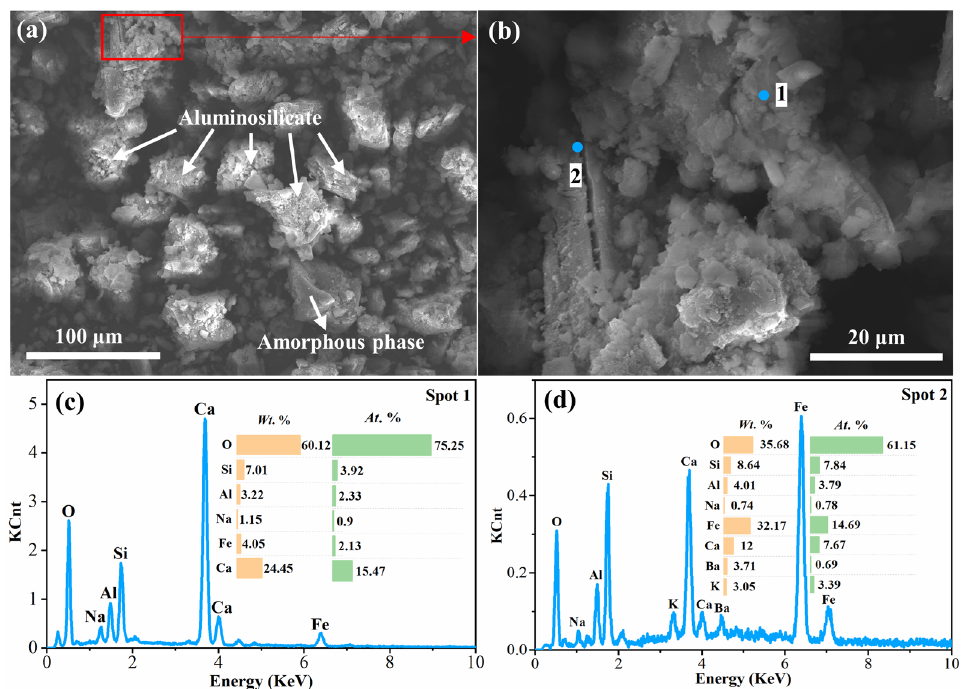
Figure 8. SEM image and EDS analysis of the water leaching residue at 10 min: ( a ) SEM image of water leaching residue at 10 min; ( b ) enlarged image for the frame area in Figure 8a; ( c ) and ( d ) EDS analysis of Spot 1 and Spot 2 in Figure 8a.